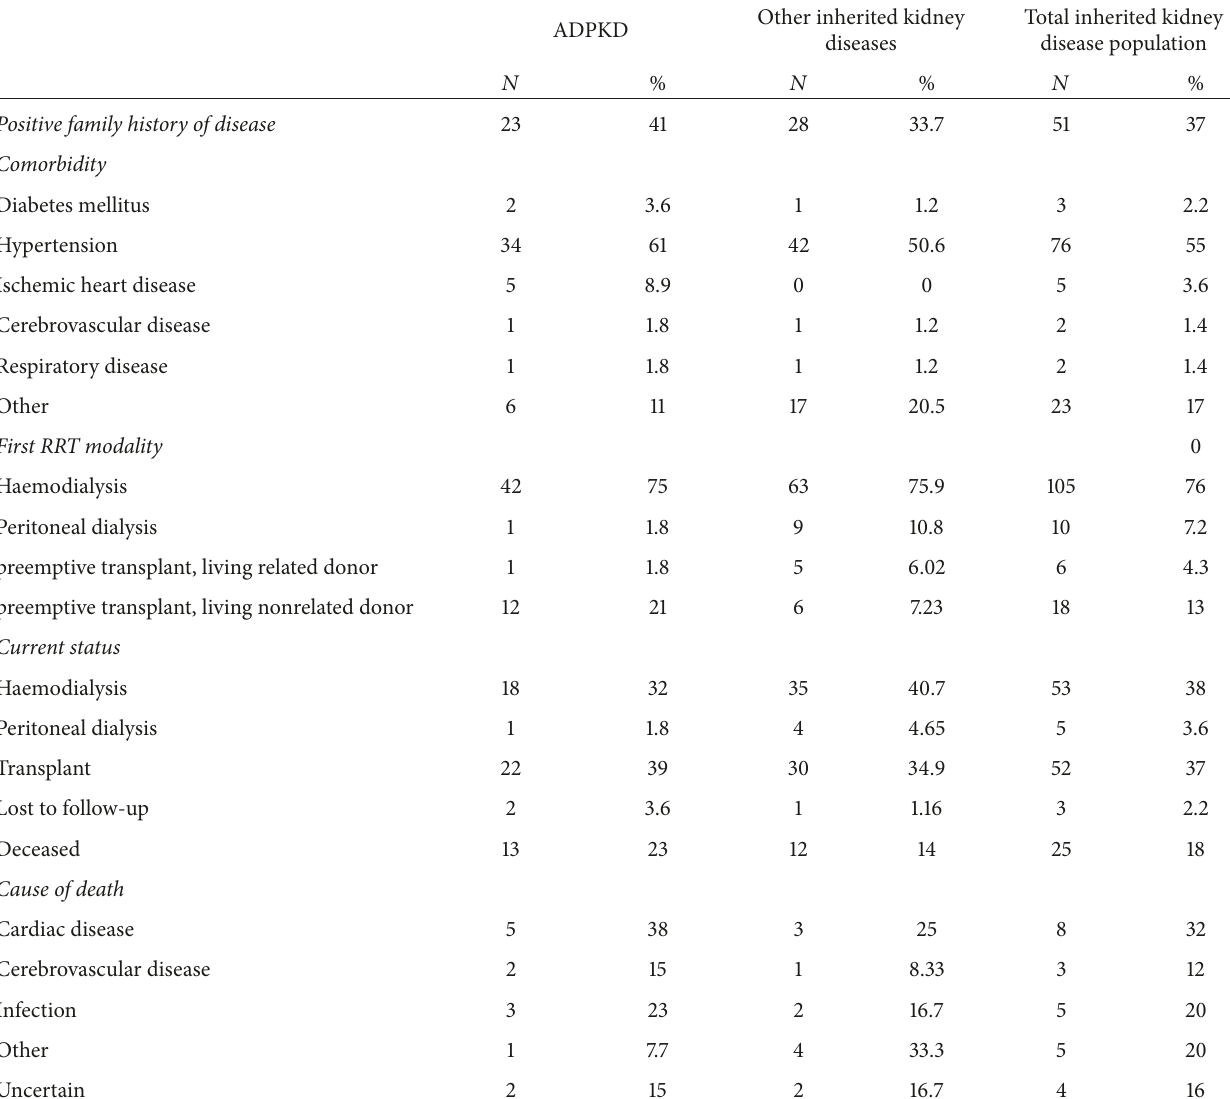
Table 4: Comparison between ADPKD and other causes of hereditary kidney